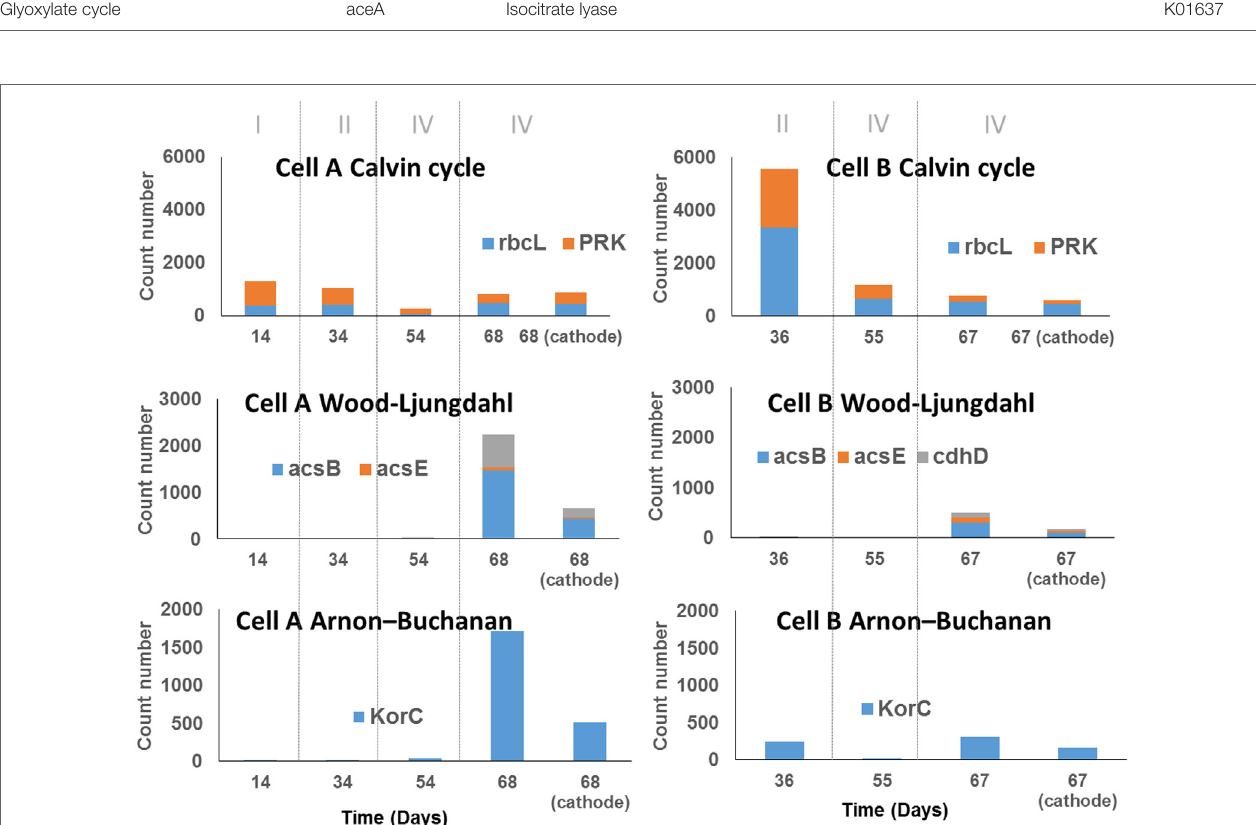
FigUre 4 | Abundance of genes encoding key enzymes of three carbon fixation pathways according to PICRUSt analysis prediction. The samples taken from the biomass in the bulk solution are indicated by the day of sampling. The sample taken from the biocathodes at the end of the experiment were indicate as the day of sampling and the word cathode. The count number was calculated as the sum of the number of reads that were assigned to the species that contain the particular gene, divided by the number of copies of the gene encoding the 16S rRNA reported for the species to which the read was assigned and multiplied by the gene replicates number in the annotated genome of the closest relative.